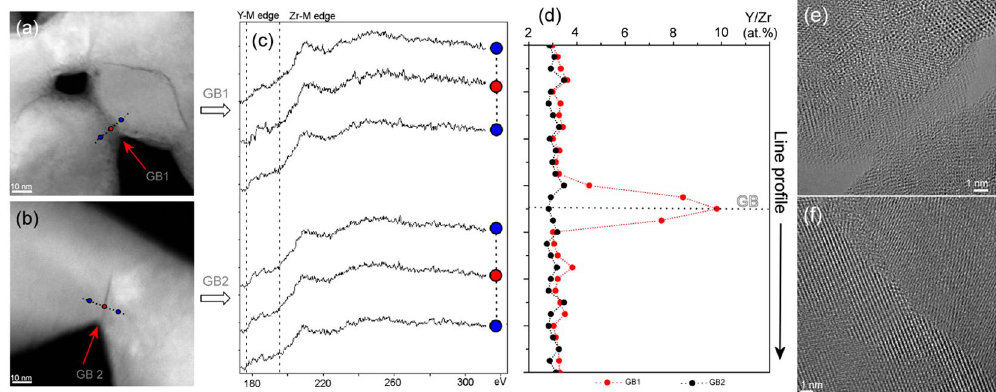
Figure 3. STEM-HAADF, EELs and HRTEM analyses of the crystallite boundaries of the 3YSZ green body sintered by the rapid (RS; 250 °C/min, 1100 °C, 2 min) and conventional (CS; 5 °C/min, 1050 °C, 2 h) sintering processes yielding similar densities of approximately 58% of theoretical density. STEM-HAADF images of ( a ) RS and ( b ) CS showing their crystallite boundaries. ( c ) EELS spectra acquisition of Y-M and Zr-M was performed in a line profile across the crystallite boundary depicted on a and b. ( d ) Concentration profile of Y/ Zr (at.%) across the crystallite boundary depicted on a and b for RS and CS samples, indicating the presence of a thin, yttria-rich, amorphous, liquid-like, intergranular film (yttria segregation) located at crystallite boundaries in the RS sample. HRTEM micrographs displaying crystallite boundaries of ( e ) the RS sample showing the presence of an amorphous layer (IGF-like film) and of ( f ) CS sample from b showing a clear, fully crystalline